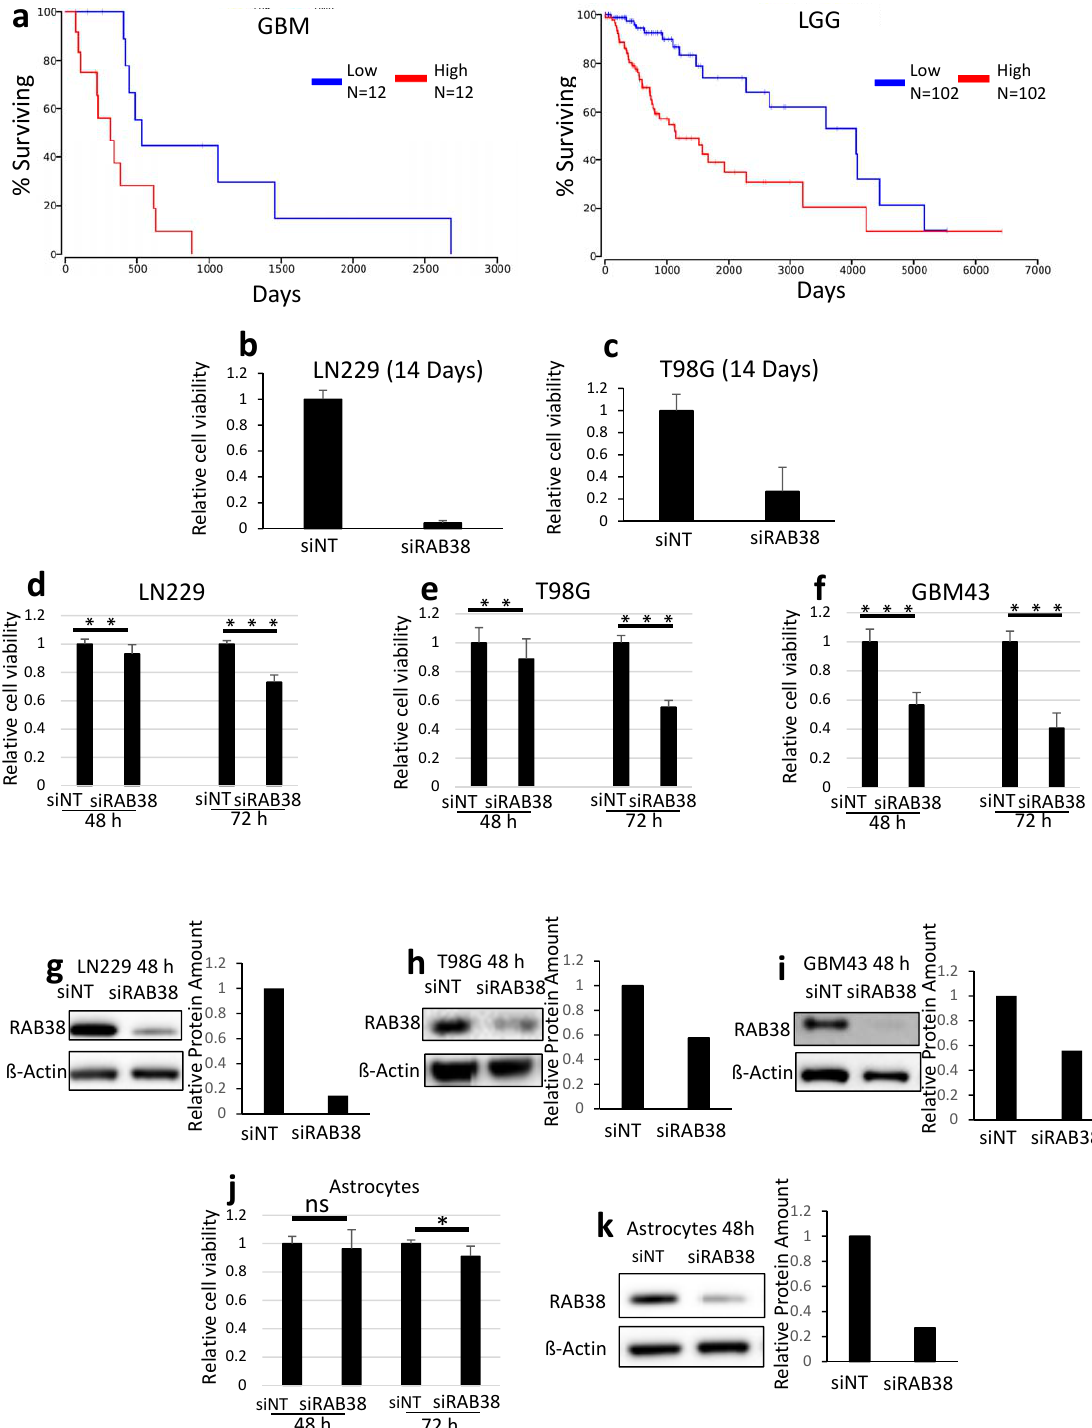
Figure 1. RAB38 silencing reduces the viability of glioblastoma cell lines. ( a ) Survival curves for high and low RAB38 expressing tumors in GBM and LGG (TCGA database) are shown. ( b – c ) LN229 ( e ) and T98G ( f ) were transfected with nontargeting (NT) or RAB38-specific siRNA (siRAB38). After 14 days, cellular viability was determined by